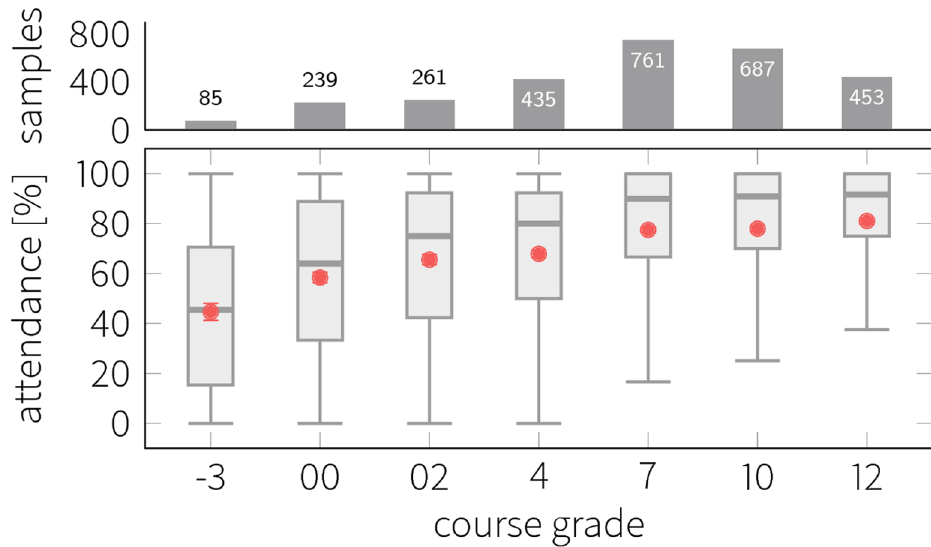
Fig 3. Class attendance conditional on grade obtained. Box plots show median values (solid horizontal line), mean values (red dots), lower and upper quartiles(box outline)and lower and upper fences (quartiles ± IQR, whiskers). Error bars mark standarddeviationof the mean. Bar chart above the boxplot shows the number of observations in each grade group.